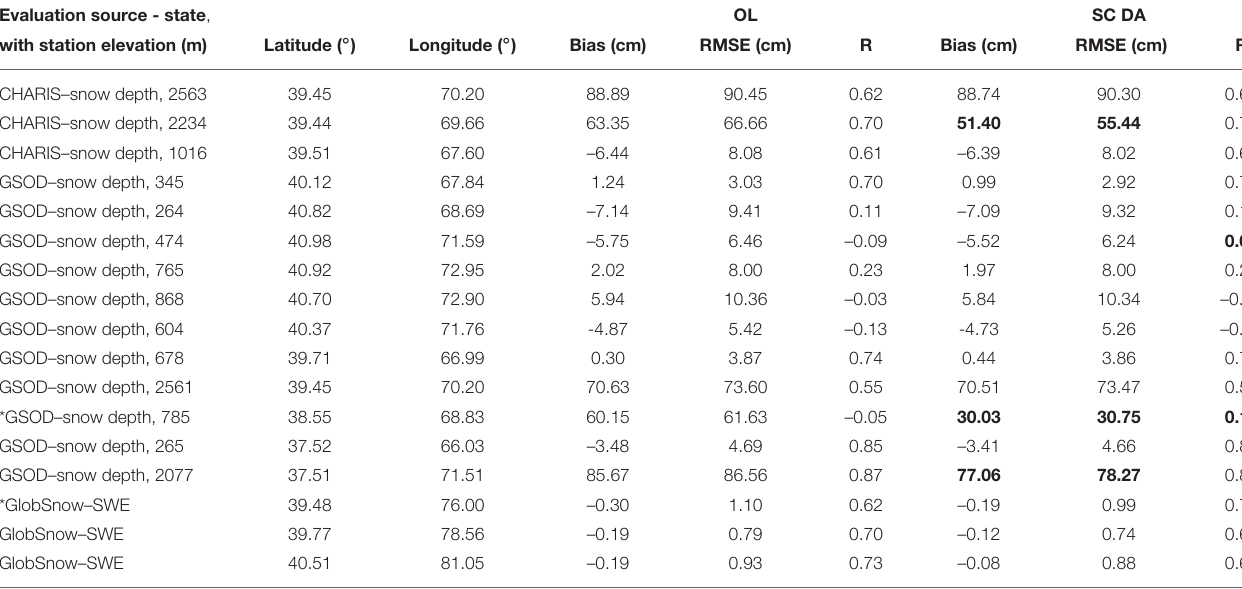
TABLE 3 | Statistics computed when comparing model derived, including both OL and SC DA derived, snow depth or SWE estimates against measurements obtained from GSOD, CHARIS, or GlobSnow. Evaluation source - state , OL SC